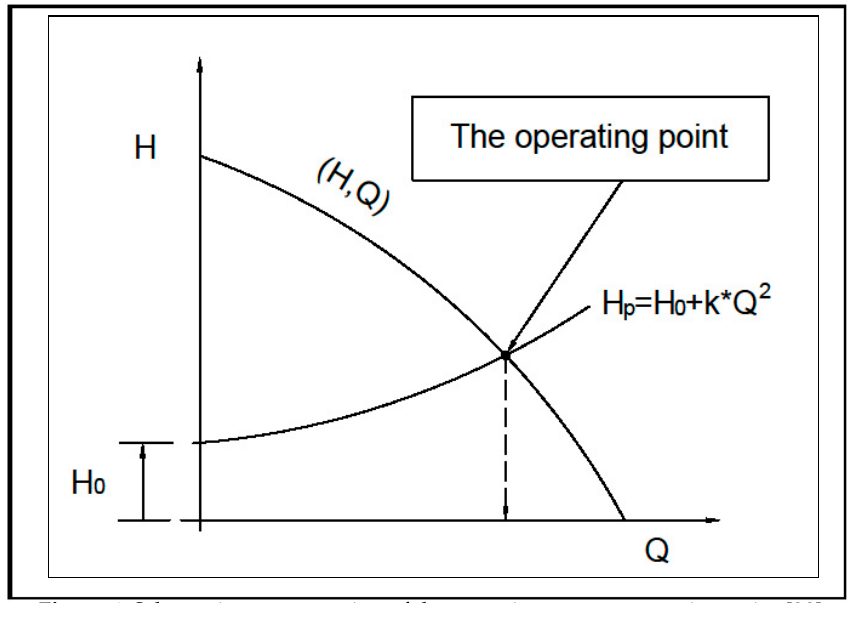
Figure 4. Schematic representation of the pumping system operating point [20].